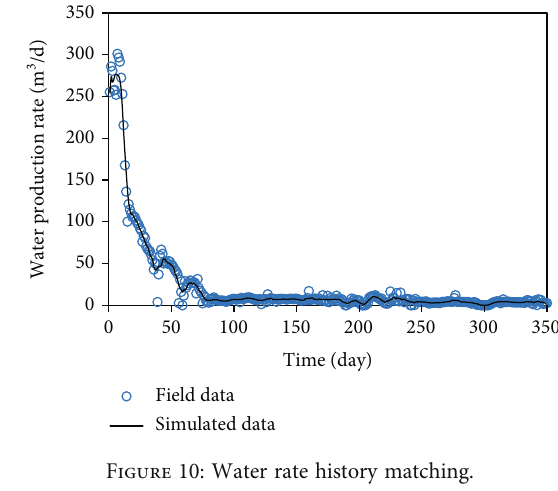
Figure 10: Water rate history matching.